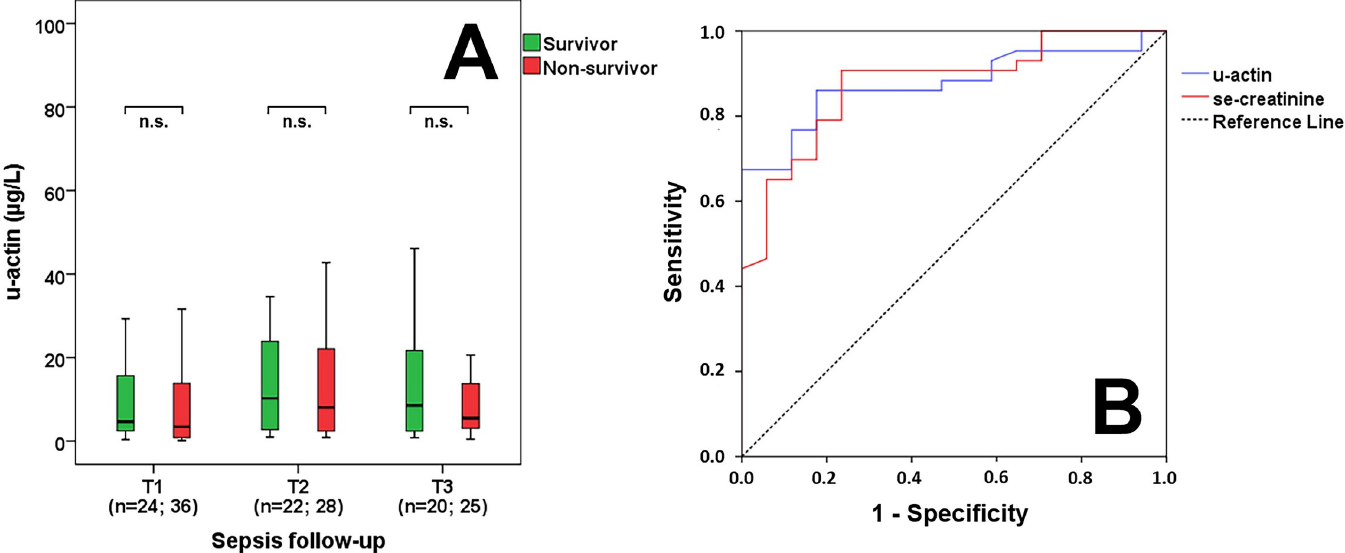
Fig 3. Survival and predictive power of urinary actin. U-actin levels in survivor and non-survivor septic patients based on 30-day mortality during follow-up (A). Receiver operating characteristic (ROC) curves of admission laboratory parameters for distinguishing sepsis from sepsis-related AKI (B). n: sample count. n.s.: non-